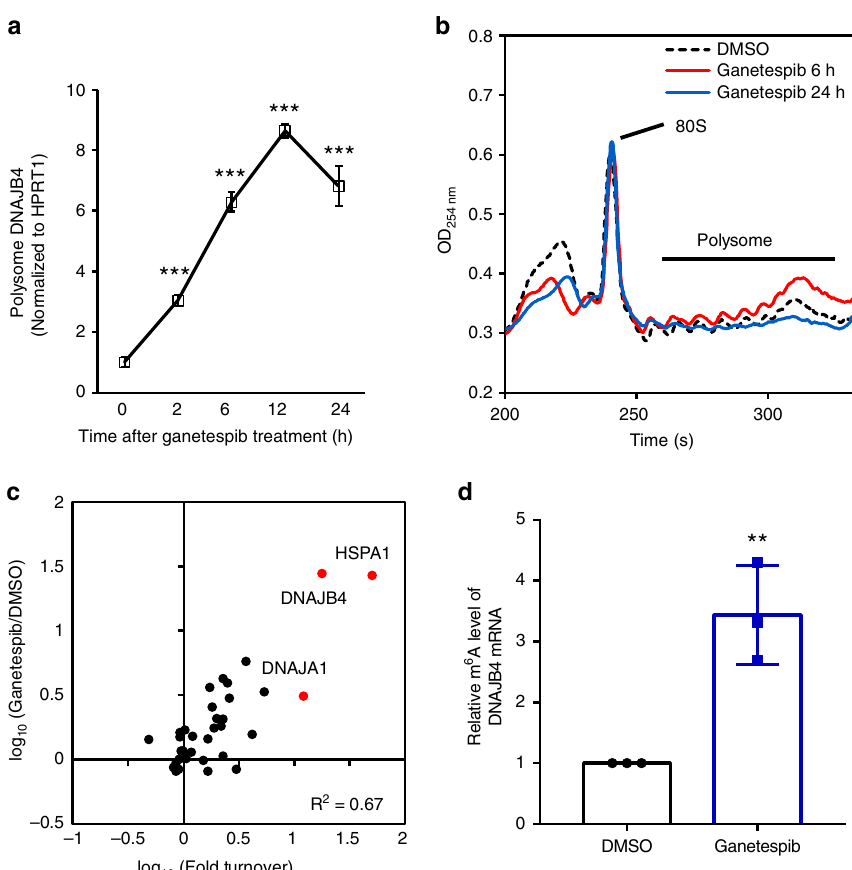
Fig. 2 Ganetespib induced increased translation of DNAJB4. a RT-qPCR results show that the mRNA level of DNAJB4 exhibited a progressive increase in the polysome fraction following ganetespib treatment in M14 cells. Data were normalized to the mRNA level of HPRT1 gene. b Traces for fractionation of polysome isolated from mock, DMSO-treated M14 cells or M14 cells at 6 or 24 h following treatment with 100 nM ganetespib (normalized to 80S). c A scatter plot shows the correlation between the expression change and protein synthesis (fold turnover) of heat shock proteins in M14 cells after ganetespib treatment. d m 6 A RIP-qPCR result shows the increased m 6 A level in DNAJB4 mRNA in M14 cells after a 6-h treatment with ganetespib. The data were normalized to the mRNA level of HPRT1 gene. The quanti fi cation data represent the mean ± S.D. of results from three independent experiments. The p- values referred to the comparison between 0 h and the indicated time points following HSP90 inhibitor treatment and were calculated based on unpaired, two-tailed Student ’ s t -test: # p > 0.05; *, 0.01 ≤ p < 0.05; **, 0.001 ≤ p < 0.01; ***, p < 0.001. Source data are provided as a Source Data fi